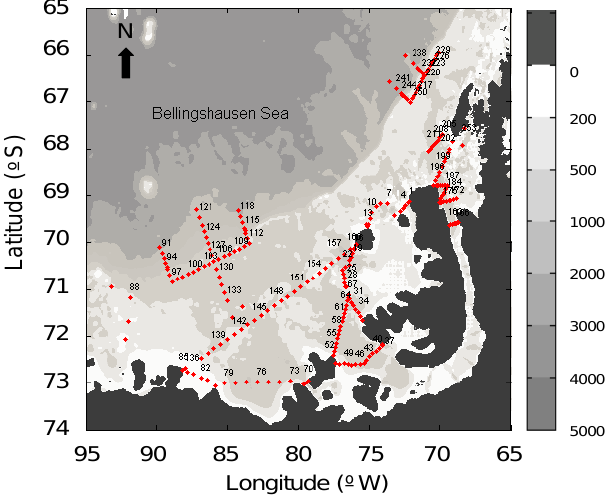
Fig. 1. CTD stations occupied by RRS James Clark Ross cruise JR165 in the Bellingshausen Sea from late summer to early autumn 2007 (3 March to 9 April 2007). Labels indicate station